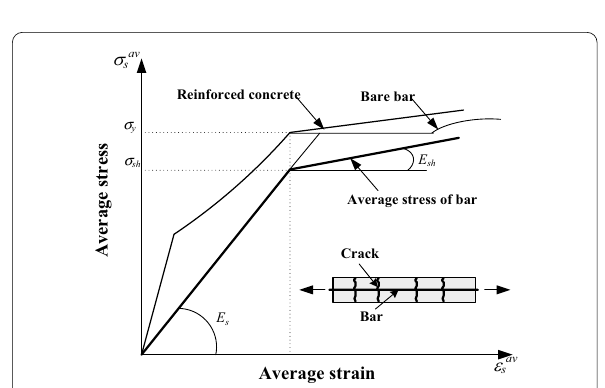
Fig. 2 Model for reinforcing bar in